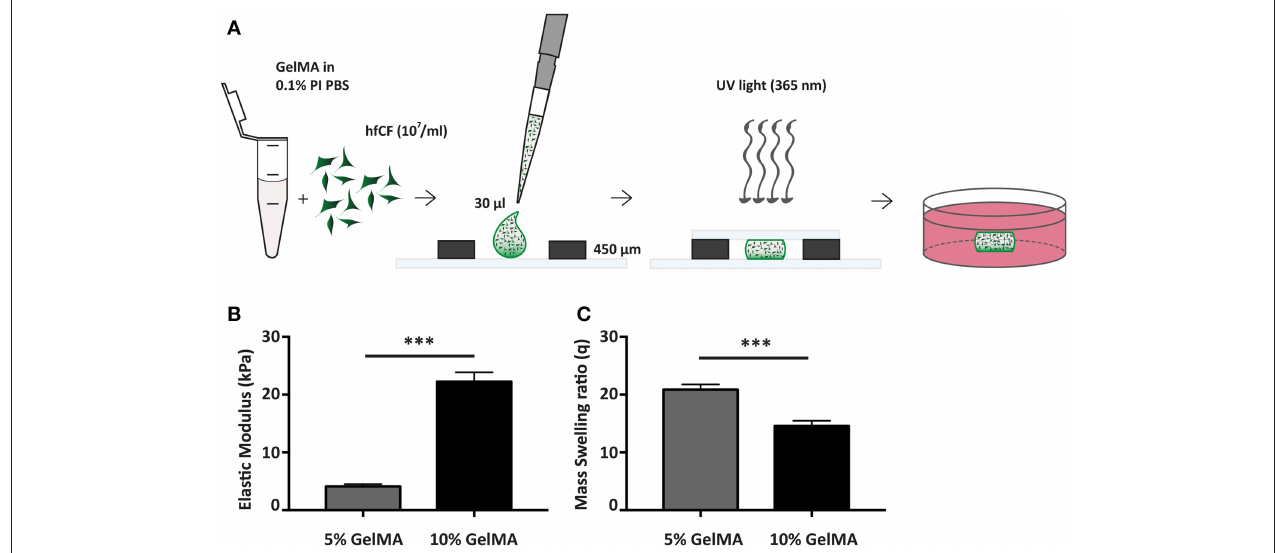
FIGURE 1 | Fabrication and mechanical characterization of GelMA hydrogels. (A) Schematic overview of hydrogel preparation. (B) Compressive properties of GelMA hydrogels upon varying gel percentage (w/v), 5% GelMA ( n = 3) and 10% GelMA ( n = 4). Statistical significance was assessed using student’s t -test (two-tailed). *** p < 0.001. (C) Mass Swelling ratio (q) differs with GelMA concentration. q = wet weight/dry weight. 5% GelMA ( n = 5) and 10% GelMA ( n = 6). Statistical significance was assessed using student’s t -test (two-tailed). *** p <